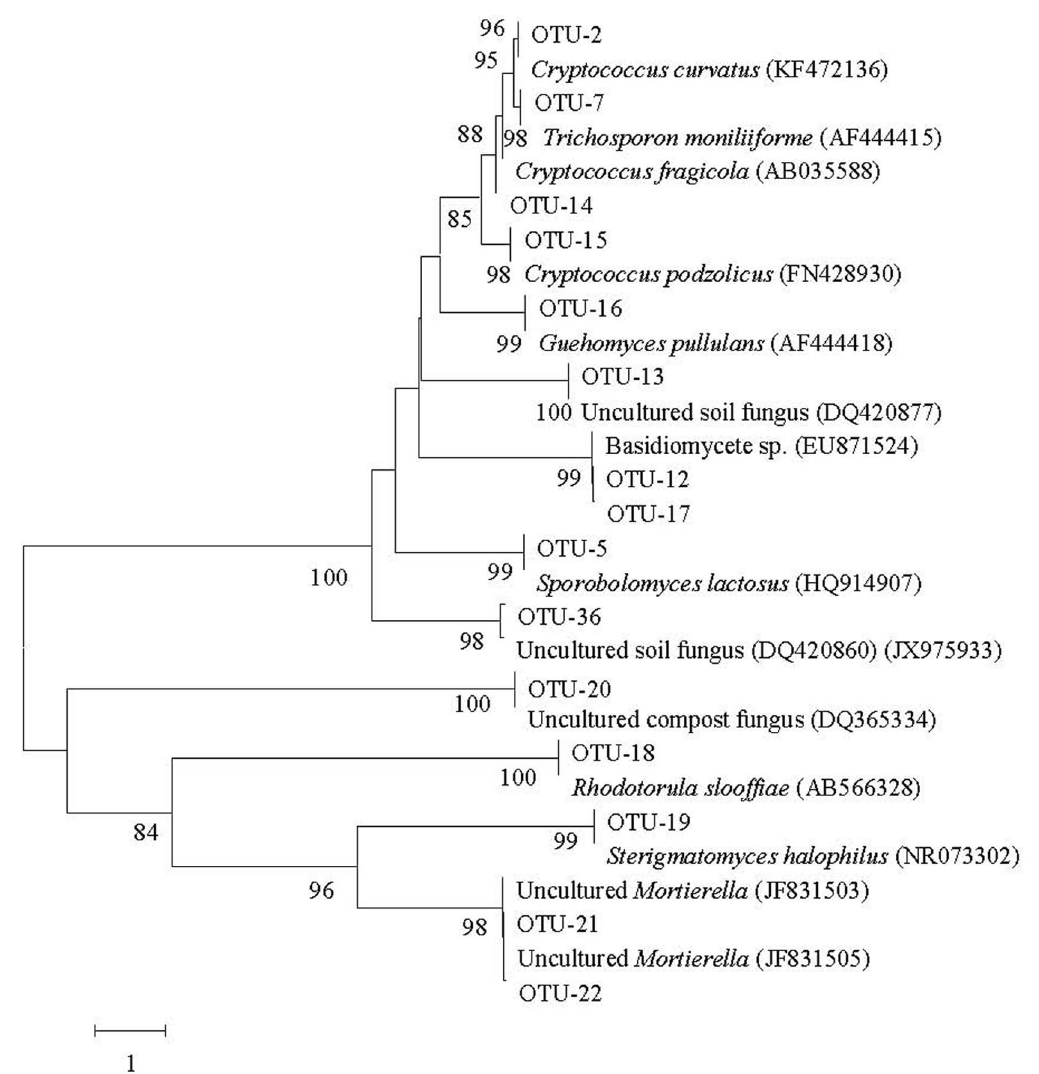
Figure 2. Neighbor-joining phylogenetic tree from analysis of ITS rDNA from 26 Basidomycota and Zygomycota representative sequences (OTU-21 and 22) in five libraries. The numbers at the nodes are percentages indicating the level of bootstrap support based on a neighbor-joining analysis of 1000 resampled data sets. Only values . 50% are shown. The scale bar represents 1 substitution per nucleotide position.